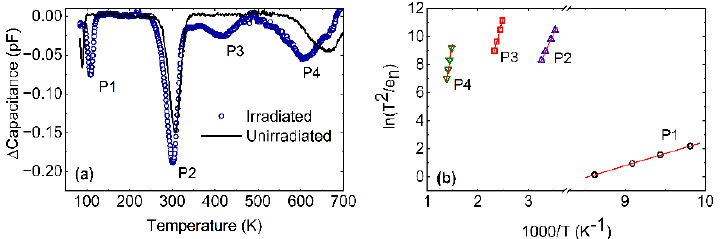
Fig. 5. (e) C-DLTS spectrum obtained for an unirradiated (solid line) the detector irradiated to a neutron fluence of 5  10 11 cm -2 (open circles). (f) Arrhenius plots corresponding to the four trap centers observed in the C-DLTS spectra of the irradiated